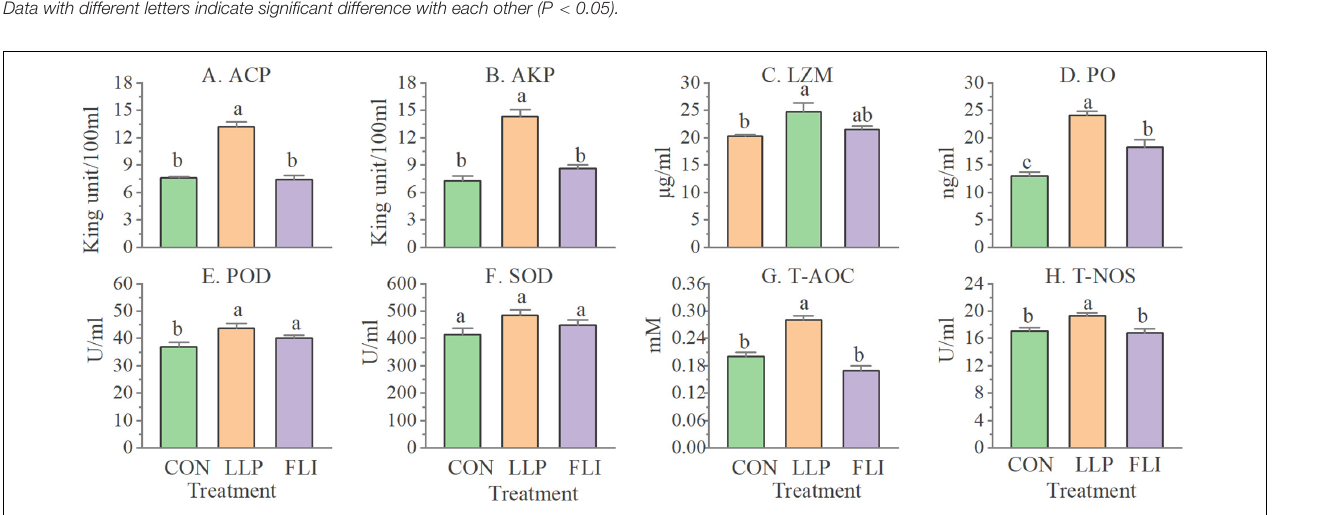
FIGURE 6 | Levels of serological immune indicators of P.